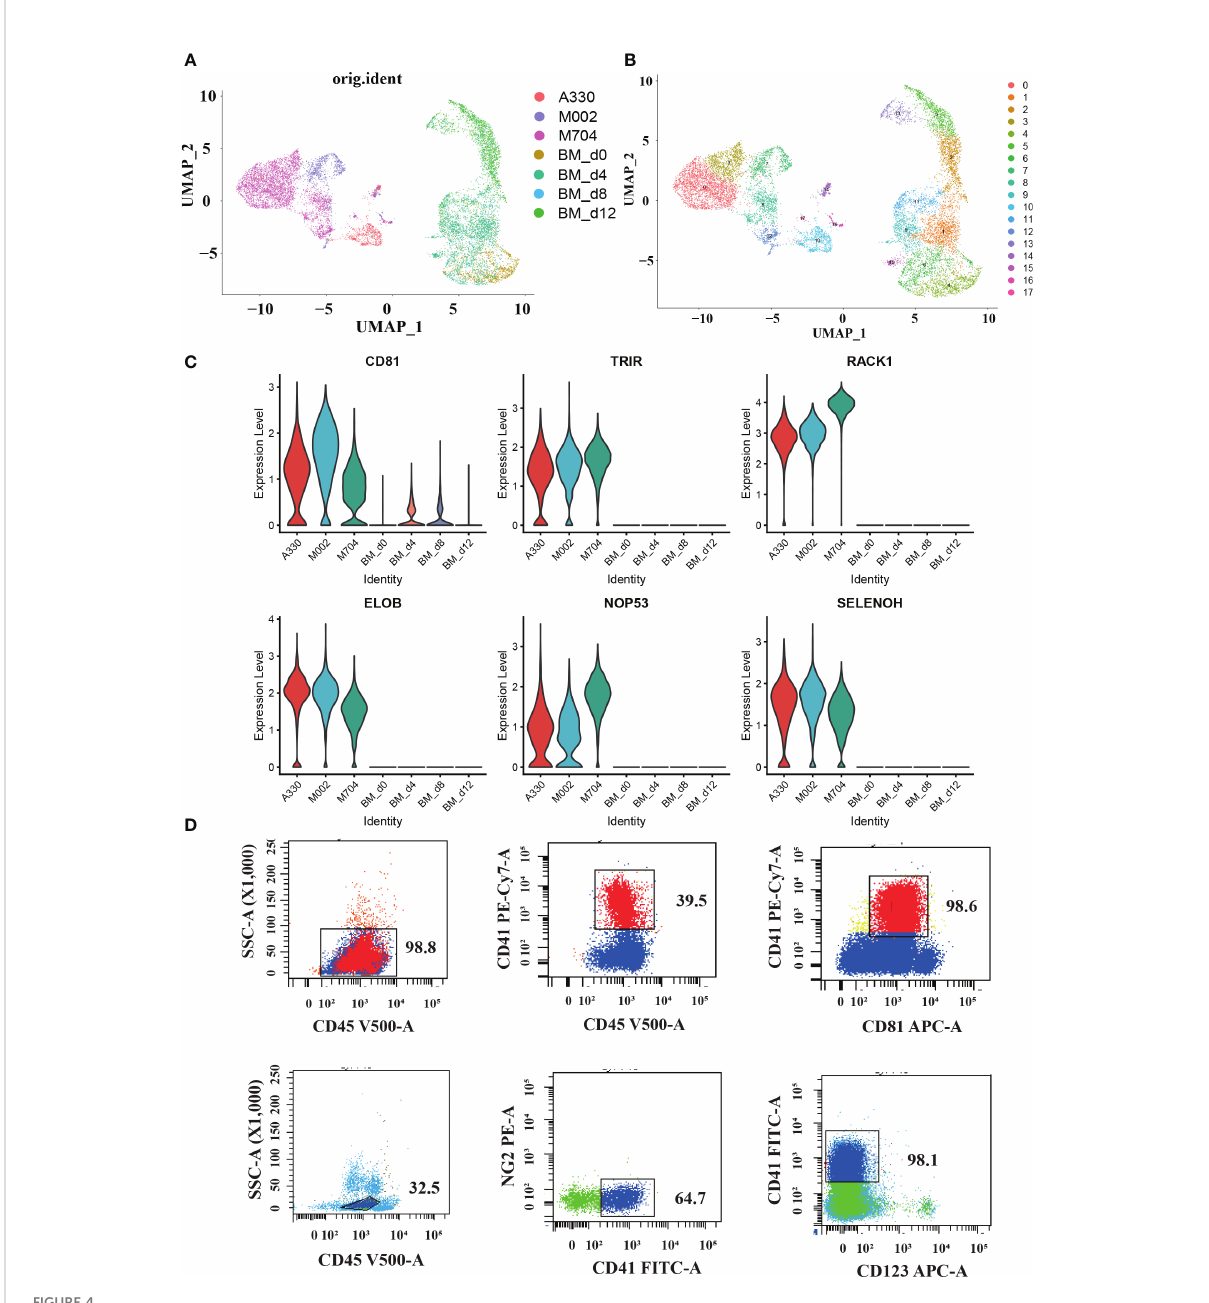
FIGURE 4 The single-cell pro fi ling of tumor cells in AMKL and normal MK cells in the bone marrow (BM). (A, B) UMAP plots of the combination of malignant AMKL cells and normal MK cells in BMs. (C) Violin plots showing candidate marker genes in abnormal megakaryoblasts. (D) Surface immunophenotype of another AMKL